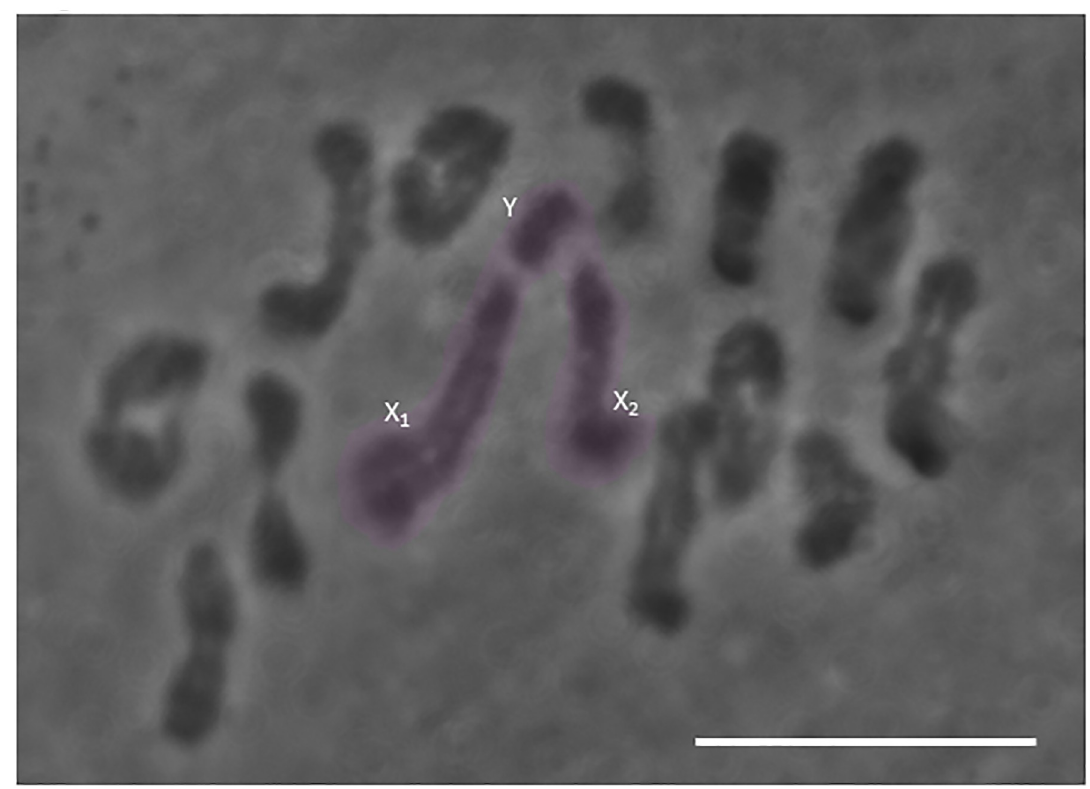
Fig 2. Aceto-orcein squash of a meiosis I spermatocyte in the praying mantis Hierodula membranacea . Twelve bivalents and one sex trivalent (highlighted in pink with component sex chromosomes noted) are present in chromosome spreads of this species. Scale bar = 5 μ